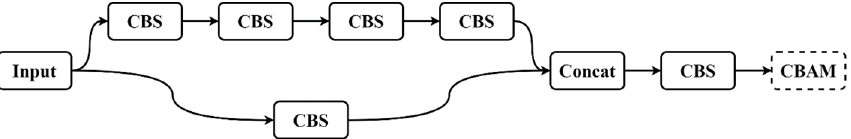
Figure 7. The improvement of the C3 module by adding the CBAM attention mechanism.